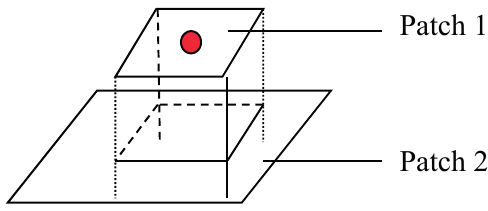
Figure 6. The determination of an inclusive relationship: (cid:1842)(cid:1853)(cid:1872)(cid:1855)(cid:1860) 1 ∈ (cid:1842)(cid:1853)(cid:1872)(cid:1855)(cid:1860) 2 .